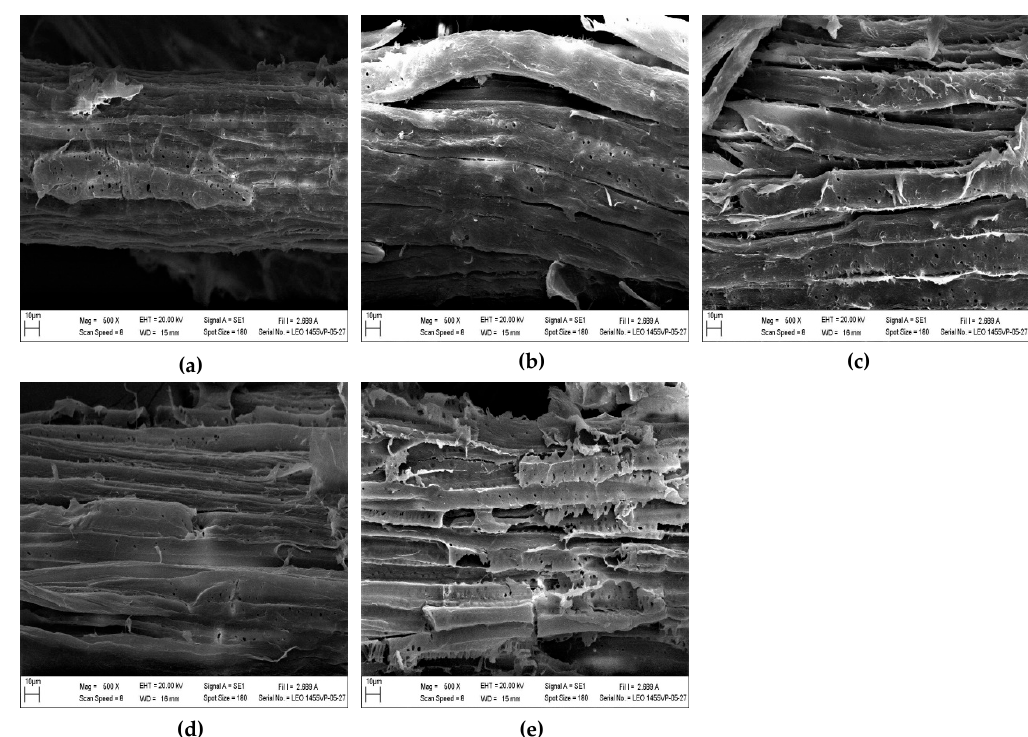
Figure 3. Scanning electron microscope (SEM) images of the ( a ) raw and NaOH-pretreated C. barbata with ( b ) 1%, ( c ) 2%, ( d ) 3%, and ( e ) 4% concentrations.